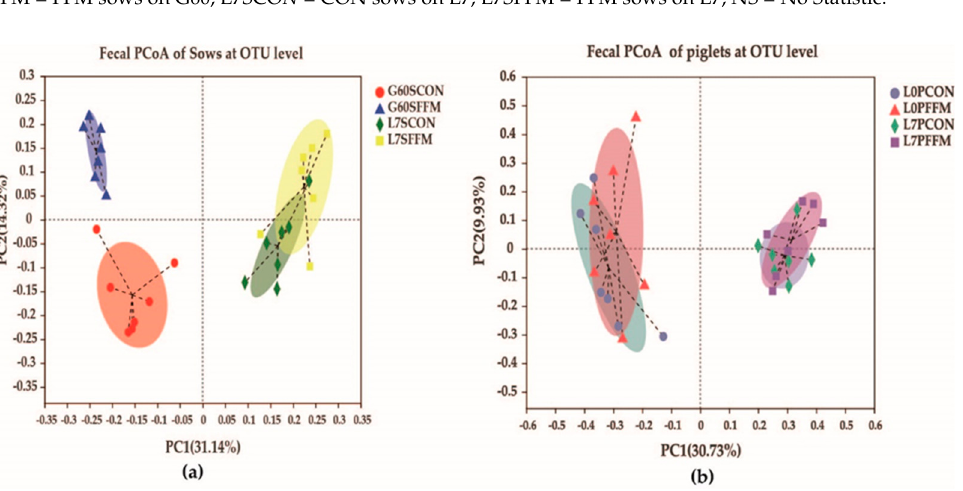
Table 2. The α diversity of sows’ feces on G60 and L7.